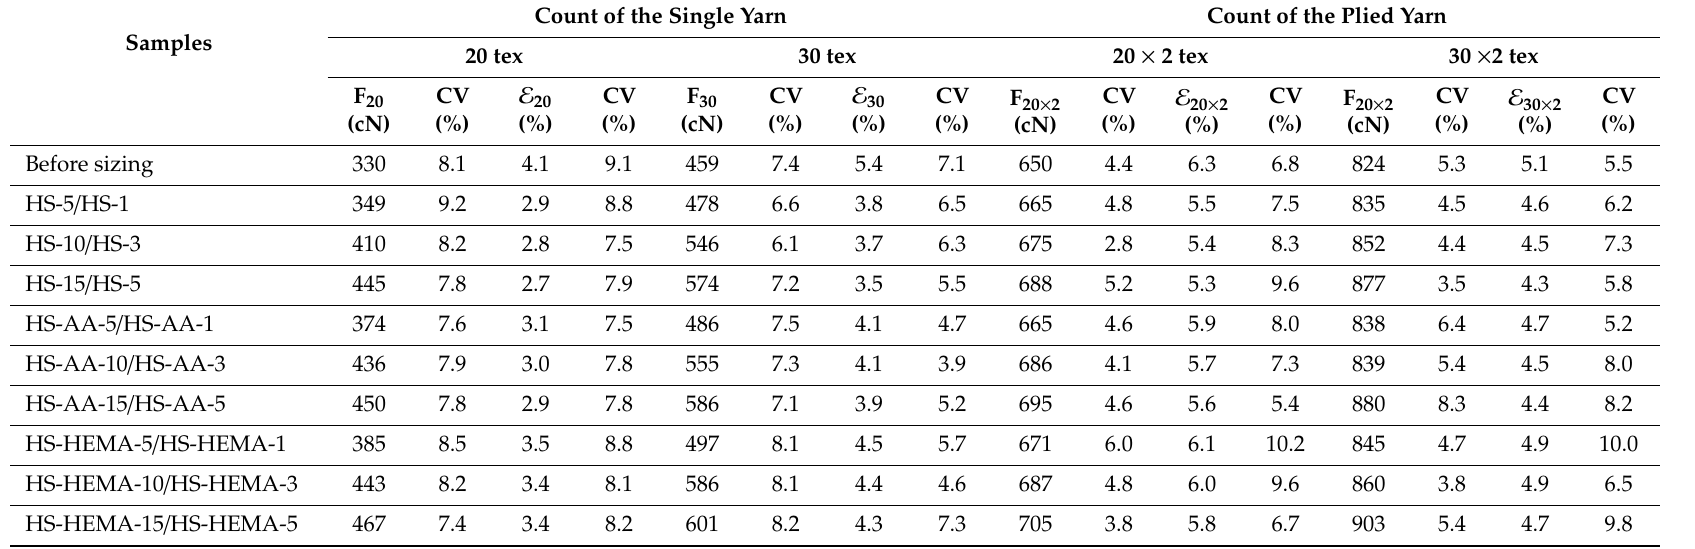
Table 7. Breaking forces and elongation at break of the yarns per yarn counts, sizing monomers and concentrations.